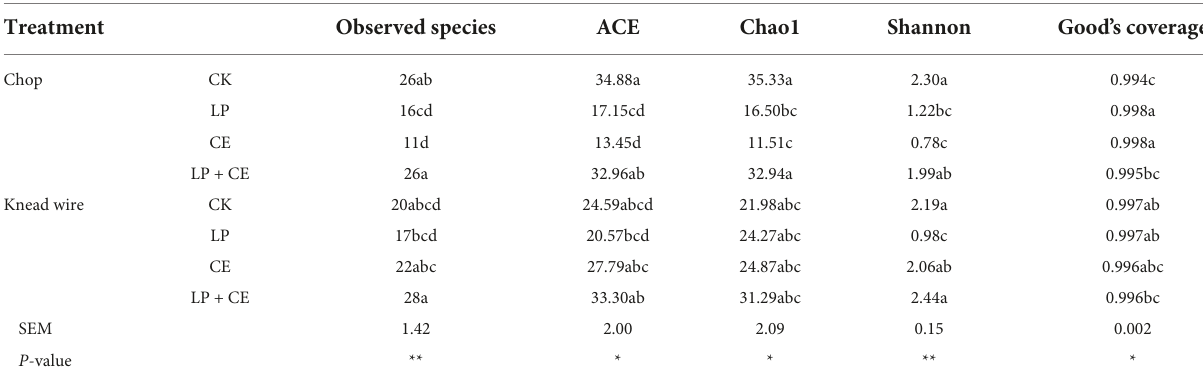
Treatment Observed